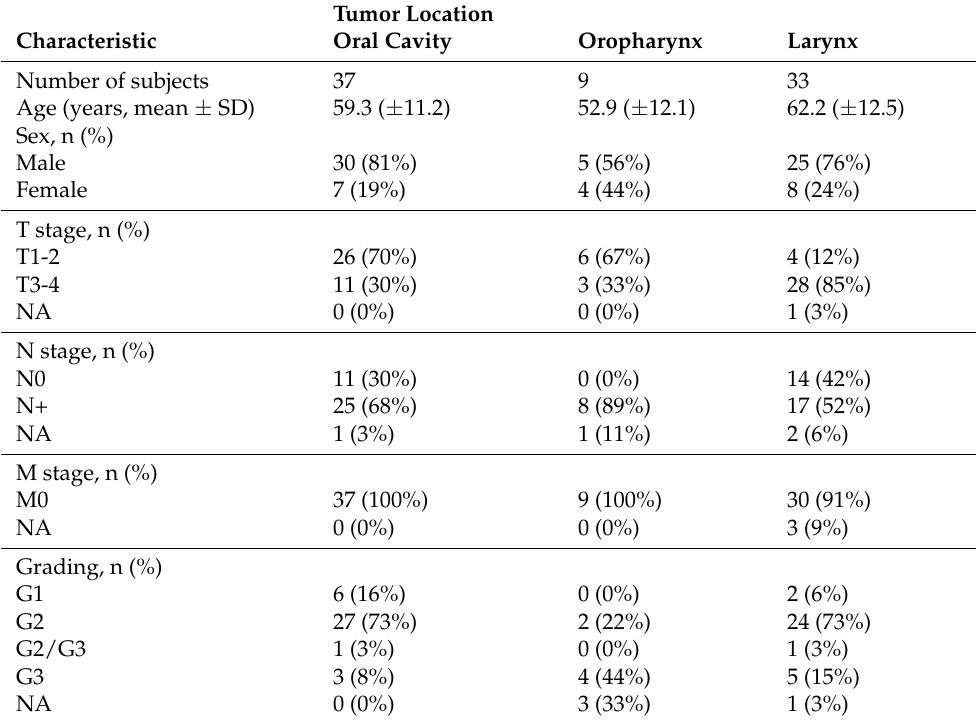
Table 1. Clinical characteristics of the study